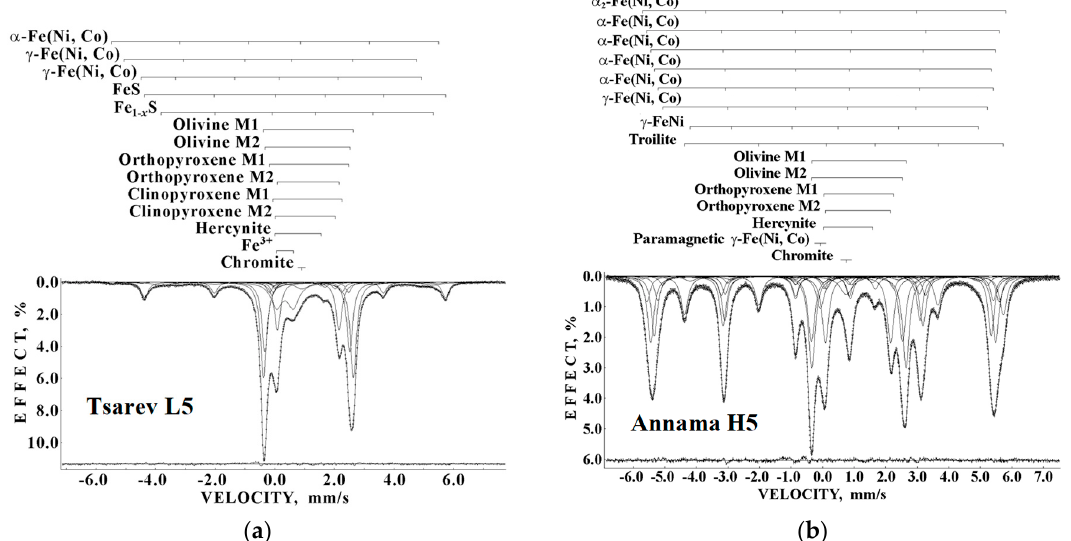
Figure 5. Mössbauer spectra of L and H ordinary chondrites: ( a ) Tsarev L5; and ( b ) Annama H5. Indicated components are the results of the best fits. The differential spectra are shown below. T = 295 K. Adopted from [14] and [12], respectively.